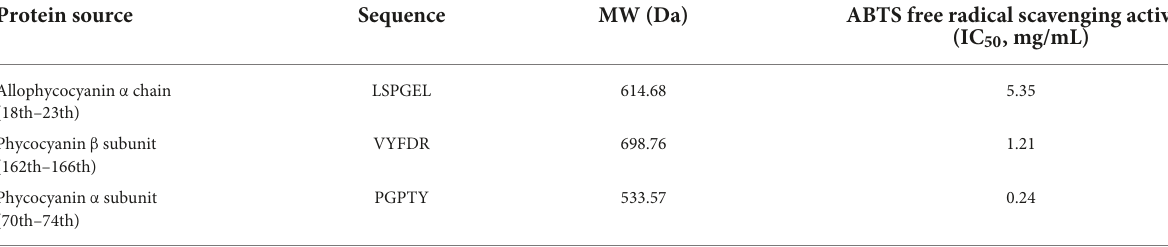
TABLE 4 Sequencing results of the antioxidant peptides obtained from G. lemaneiformis . Protein